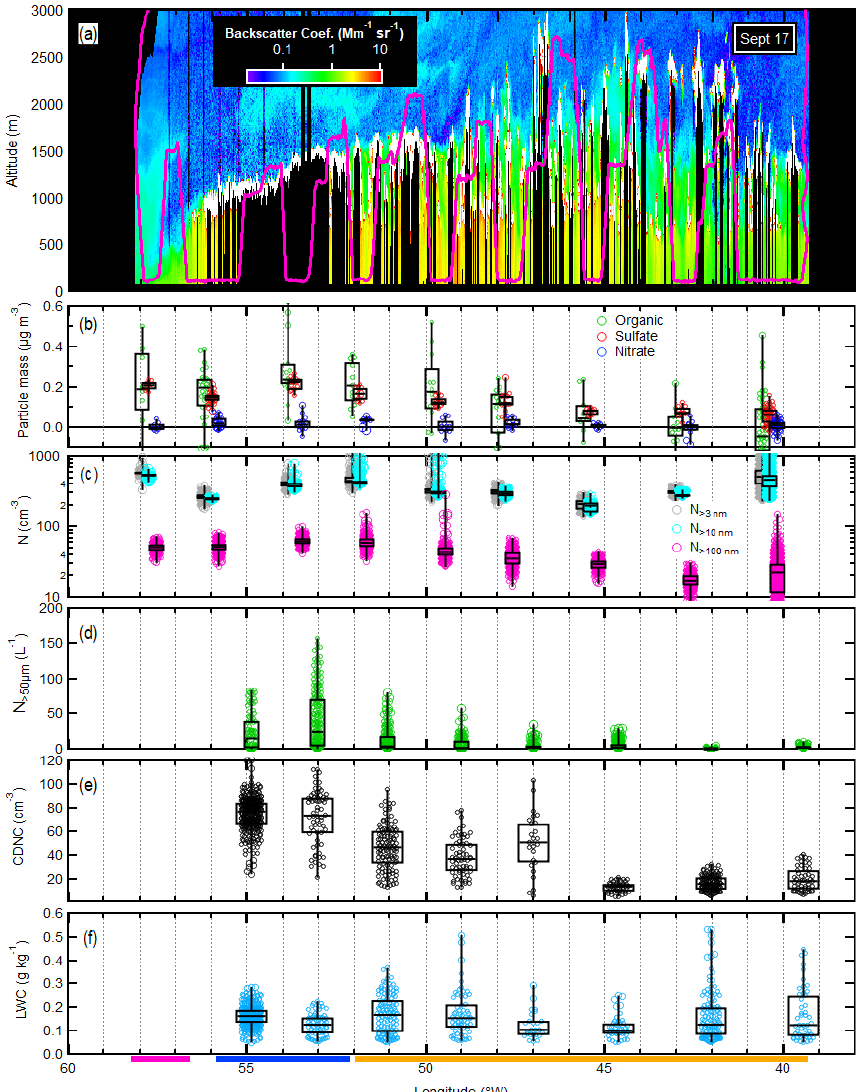
Figure 3. C130 particle measurements collected on the 17 September 2017 flight. The (a) C130 HSRL backscatter overlaid with C130 altitude (magenta), (b) non-refractory particle mass composition, and (c) particle concentrations ( N ) for particles > 3, > 10, and > 100nm in diameter. In-cloud (d) precipitation from the CIP (diameter > 50µm) and (e) CDNC (diameter range of 2–50µm) and (f) LWC from the CDP are shown with box plots for each in-cloud leg. All measurements are presented as a function of longitude. The high-altitude HSRL back scattering measurements were made immediately after the surface measurements along the same horizontal flight track but in reverse (Fig. 1c–e). Magenta, blue and orange lines, at the bottom of panel (f) , represent the approximate longitudes with cloud-free, closed-cell and open-cell clouds, respectively. Note that while negative particle mass measurements are not possible, they are included to prevent exclusion of the negative bias in the AMS